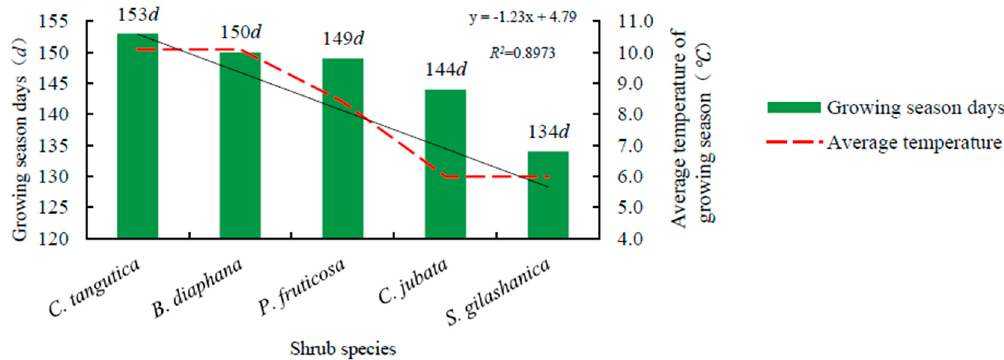
Figure 2. Relationship between the growing season length and the average temperature.